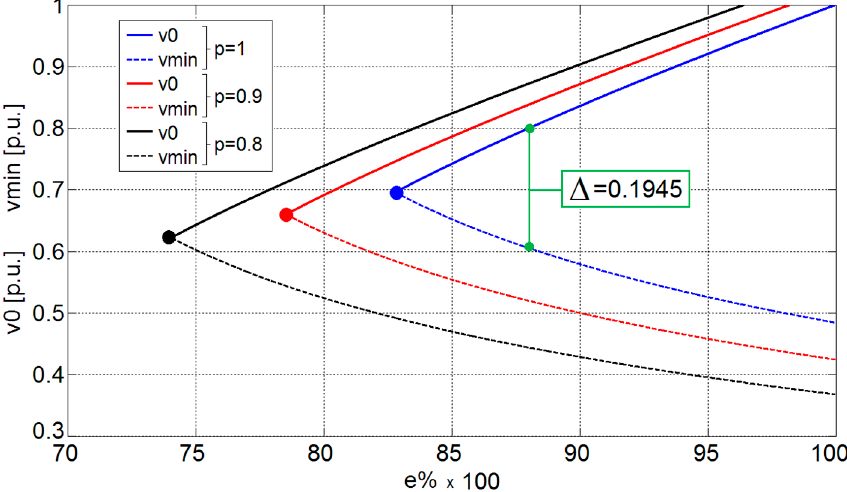
Figure 7. Stability index ∆ , with varying constant power load (CPL) power and DC bus